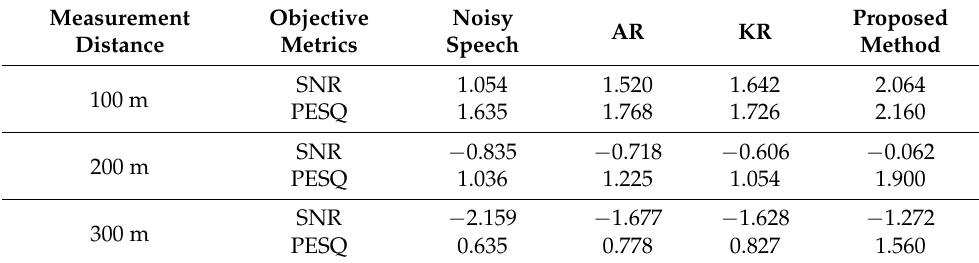
Table 1. SNR and PESQ-based objective evaluation